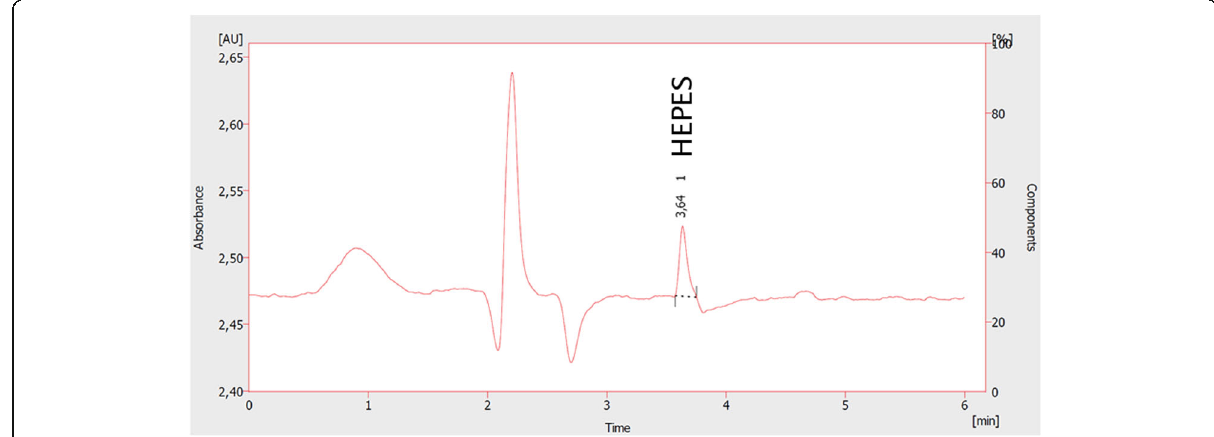
Fig. 4 Representative HPLC chromatogram of HEPES (35 μ g/mL) obtained by the method according to Antunes et